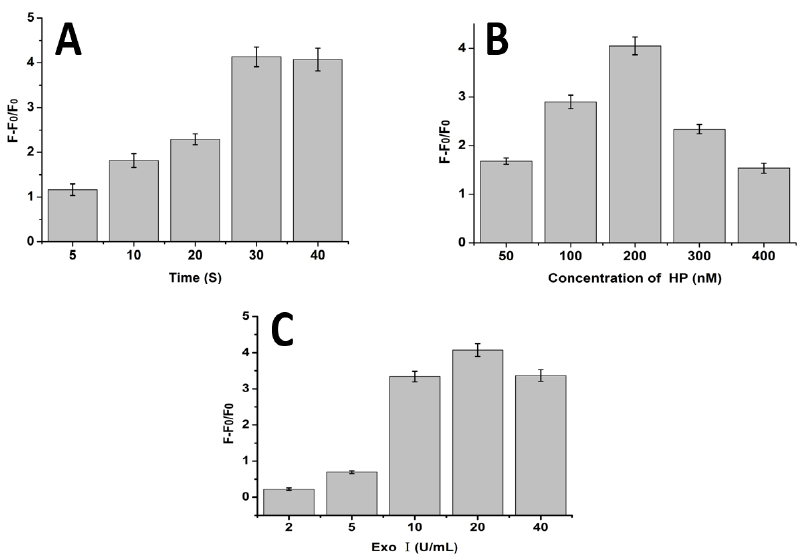
Figure 3. Optimization of miRNA detection conditions. ( A ) Bar graph showing the relationship between reaction time and (F0-F)/F0. Each sample contained 200 nM HP, 200 nM miRNA, and 20 U/mL exo I. ( B ) Bar graph showing the relationship between the concentration of HP and (F0-F)/F0. In each sample, 200 nM miRNA and 20 U/mL exo I were present. ( C ) Bar graph showing the relationship between the concentration of exo I and (F0-F)/F0. In each sample, 200 nM HP and 200 nM miRNA were present. Error bars were estimated from three replicate measurements.